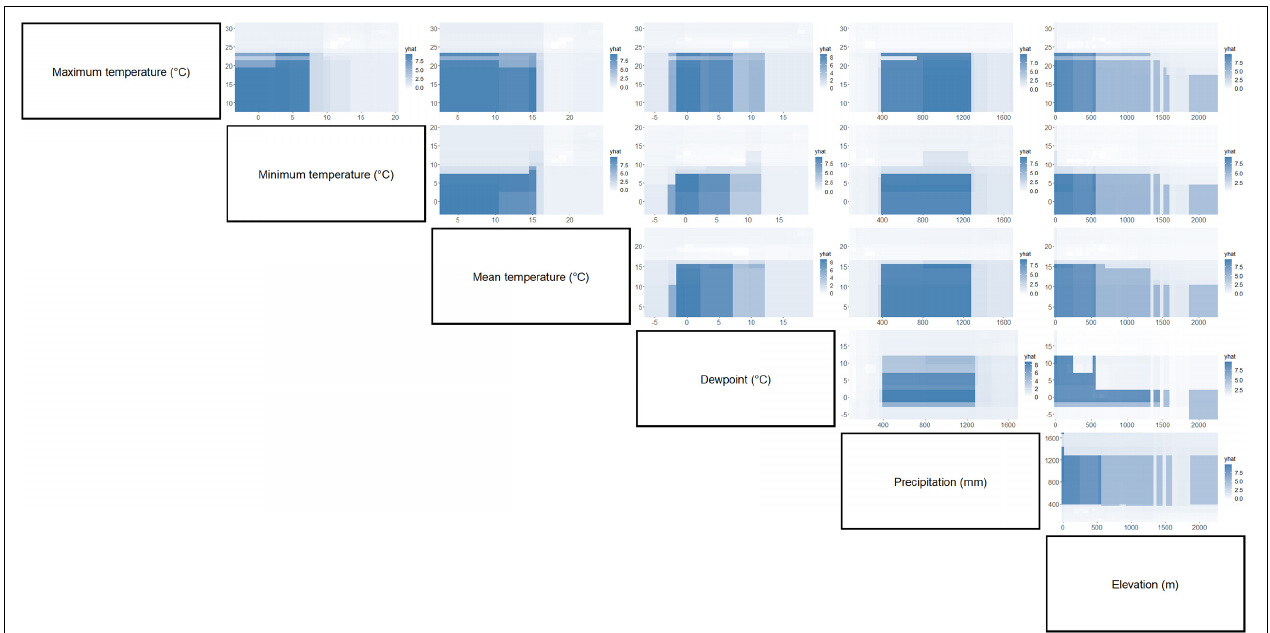
FIGURE 5 | Partial dependence plots of paired environment parameters showing their association with C . pipiens occurrence. Intensity of color is proportional to partial dependence of C . pipiens occurrence on various climate factors.